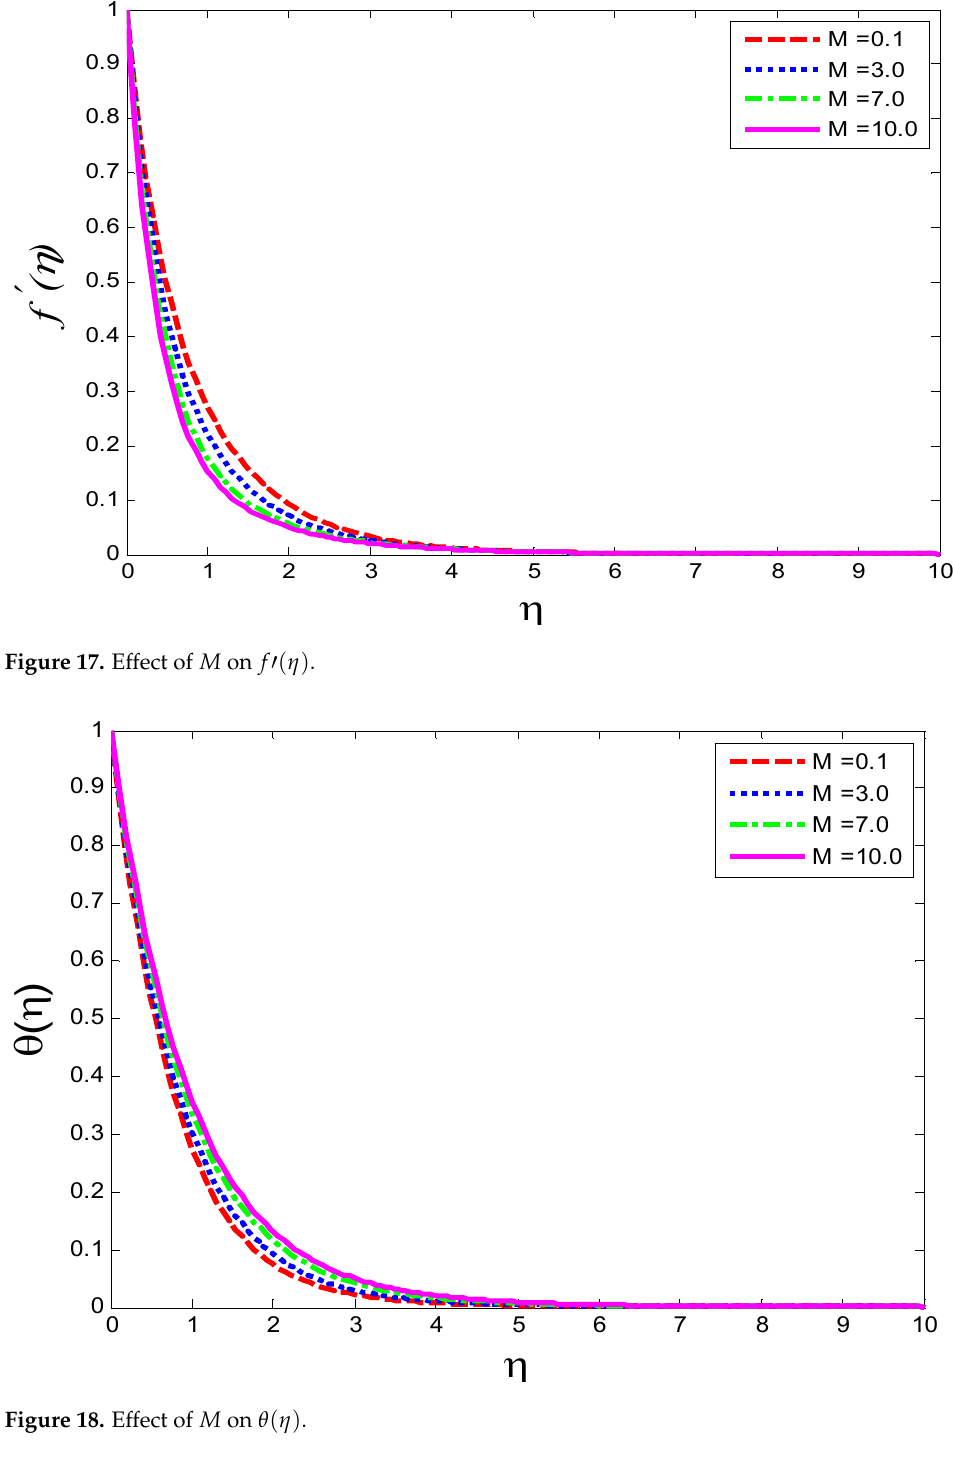
Figure 16. Effect of 𝑃𝑟 on 𝜃(cid:4666)𝜂(cid:4667) .